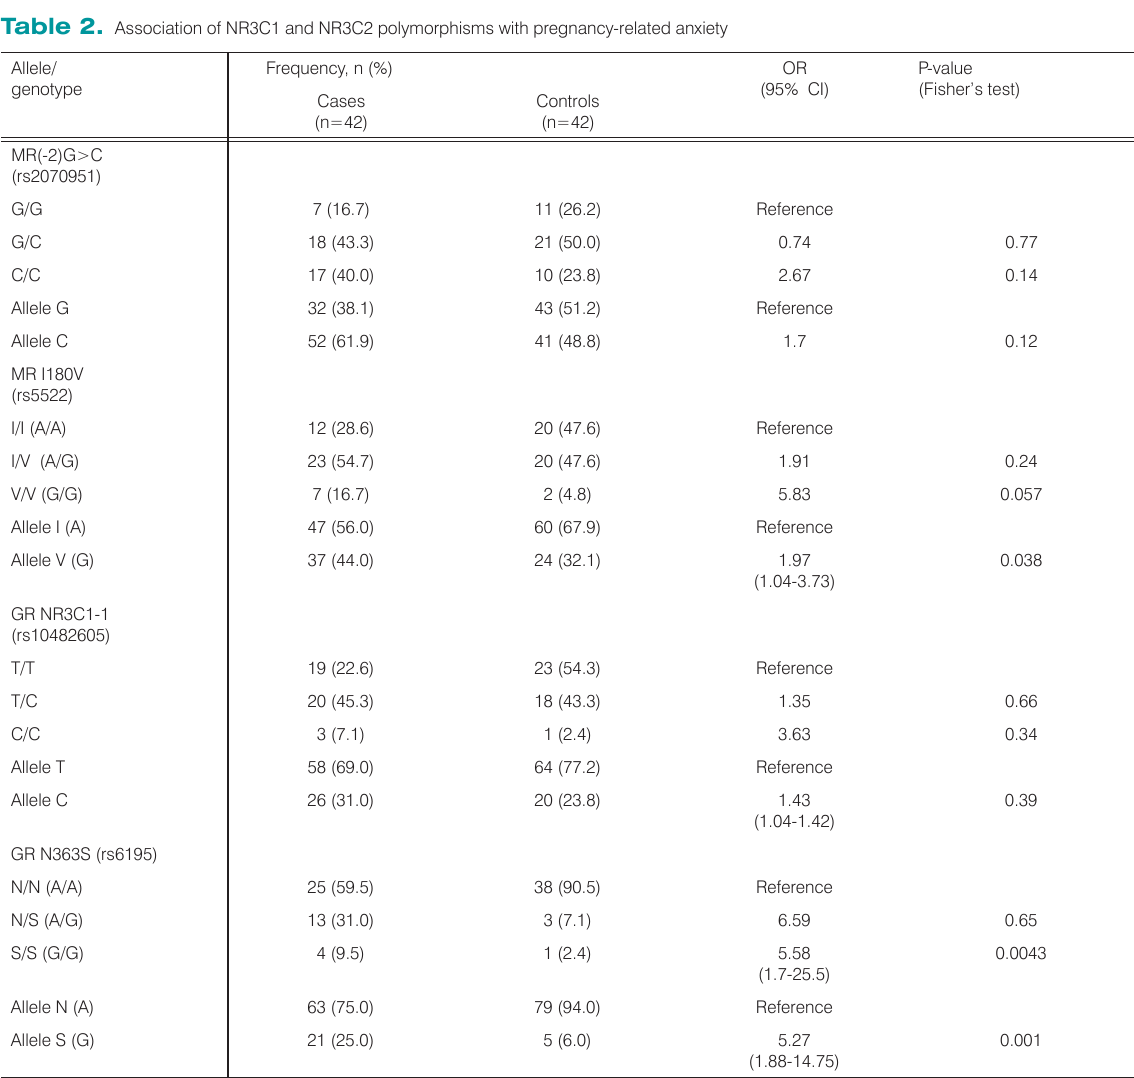
Table 2. Association of NR3C1 and NR3C2 polymorphisms with pregnancy-related